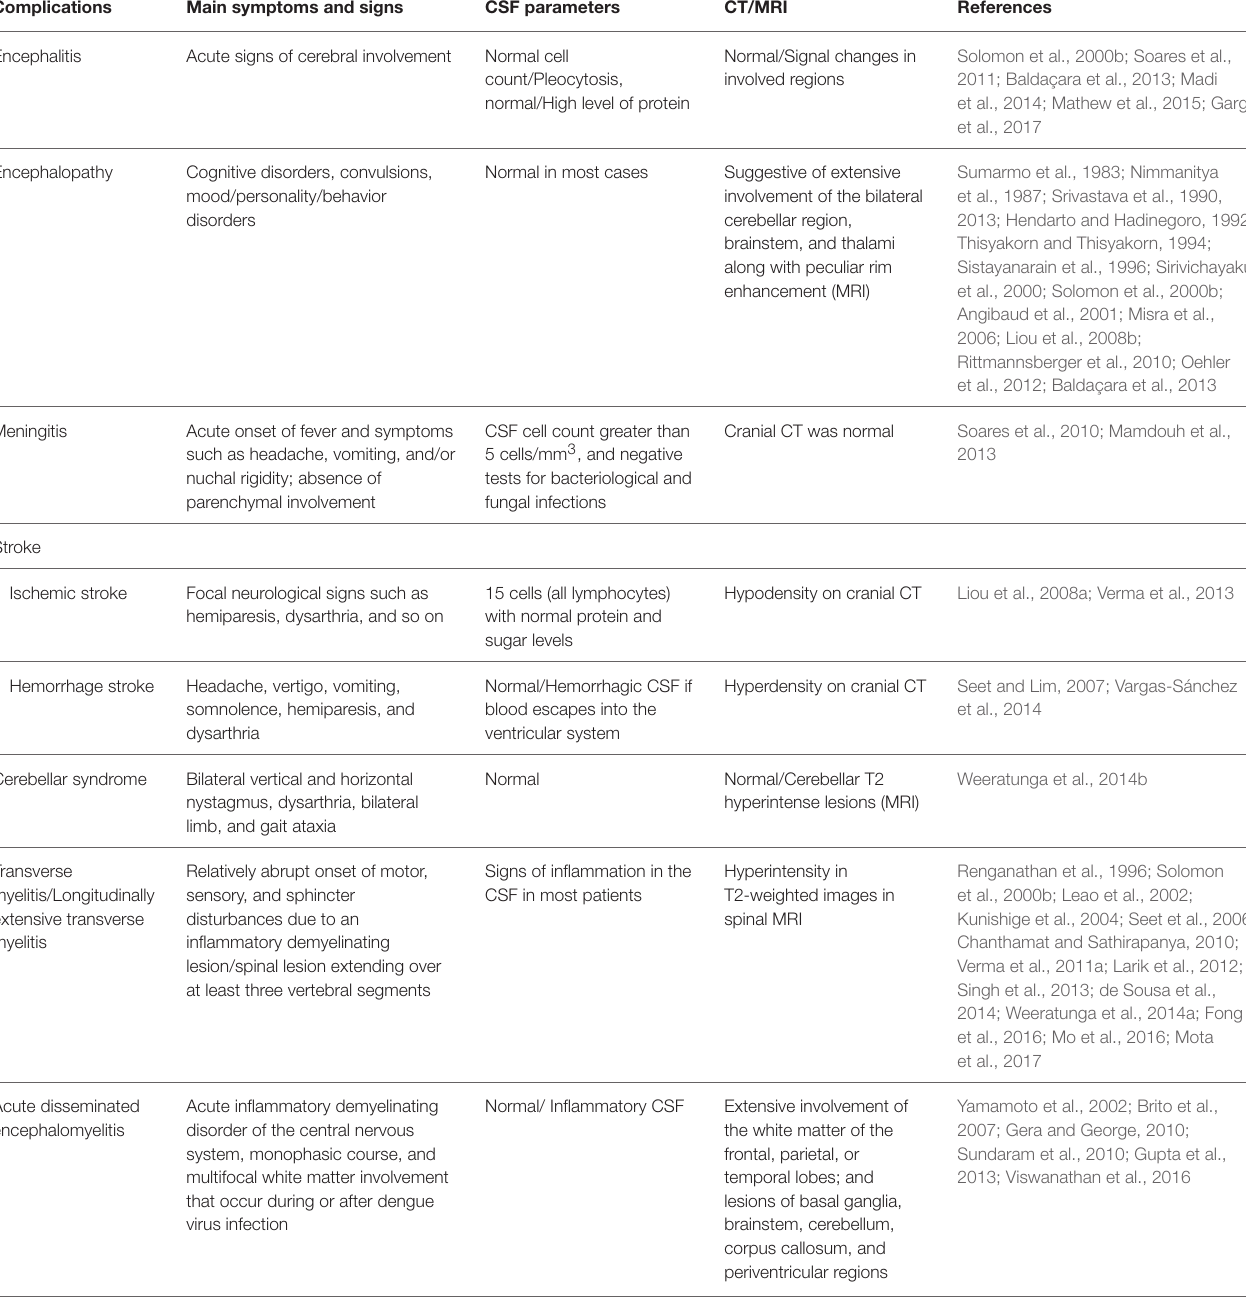
TABLE 1 | Main central neurological system complications associated with dengue